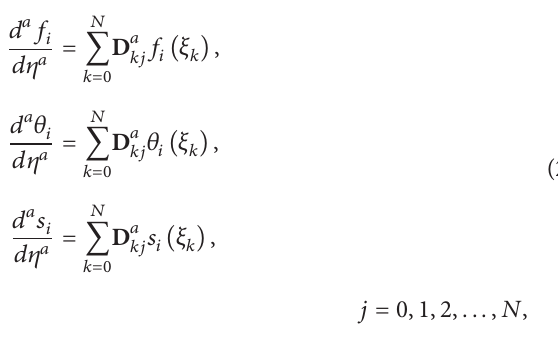
Table 1: Comparison of values of −𝜃 󸀠 (0) for aiding and opposing